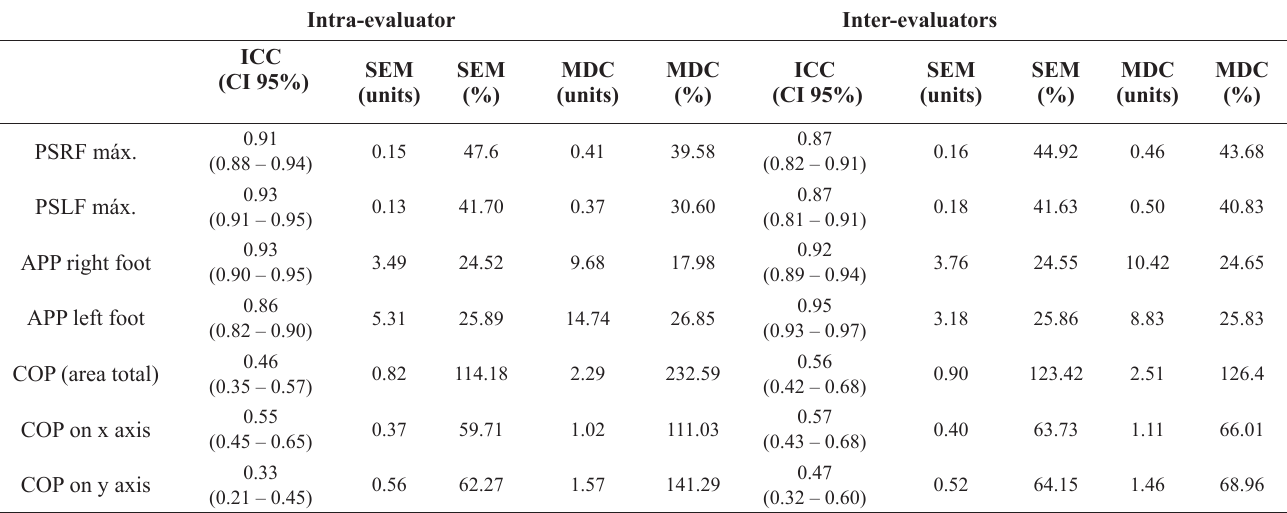
Intra-evaluator Inter-evaluators ICC SEM SEM MDC MDC ICC SEM SEM MDC MDC (CI 95%) (units) (%) (units) (%) (CI 95%) (units) (%) (units) (%)